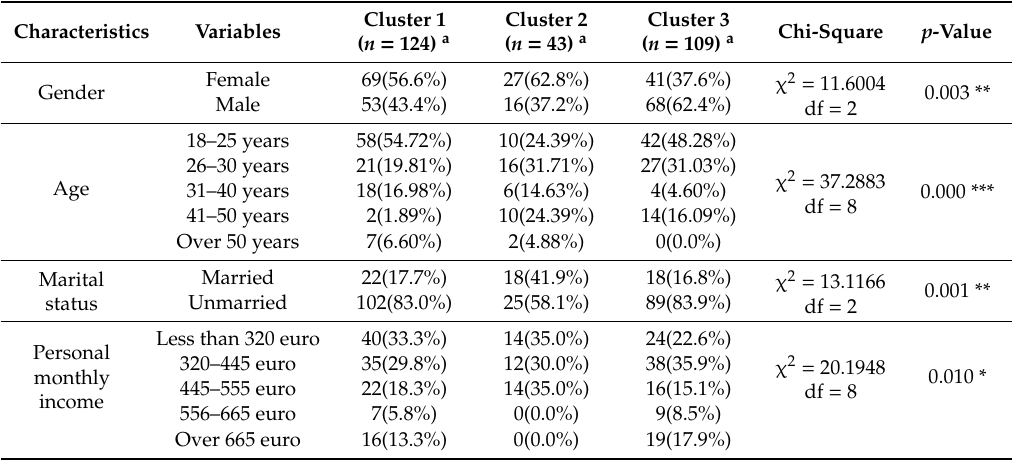
Table 7. Demographic profile of consumers.